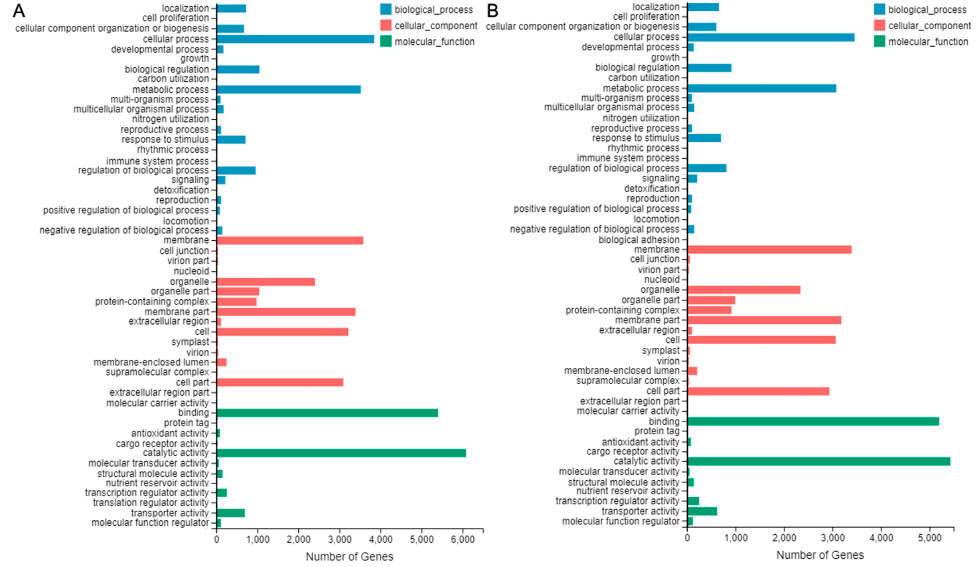
Figure 8. GO annotation of DEGs between ‘SO’ and ‘ZH’. ( A ) GO annotation of up-regulated DEGs; ( B ) GO annotation of down-regulated DEGs.